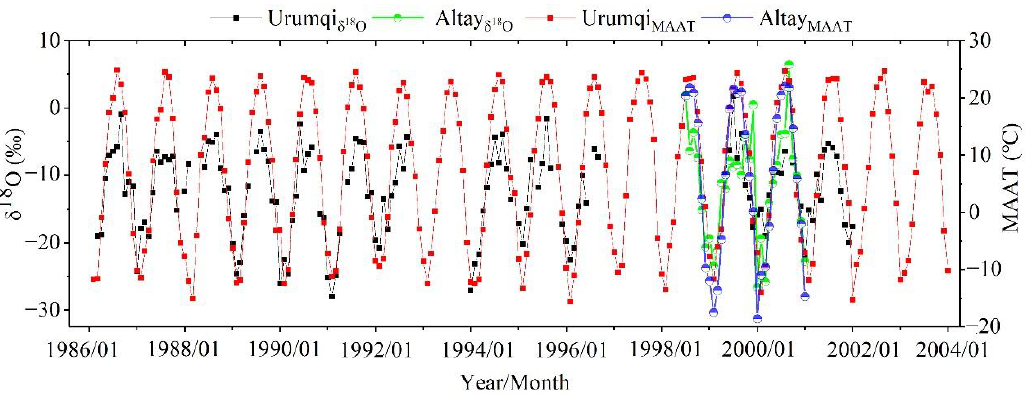
Figure 7. Monthly average air temperature (MAAT/°C) and monthly amount-weighted average δ 18 O in Urumqi (January 1986 to December 2003) and Altay (June 2000 to December 2002). MAAT represented the monthly average air temperature.